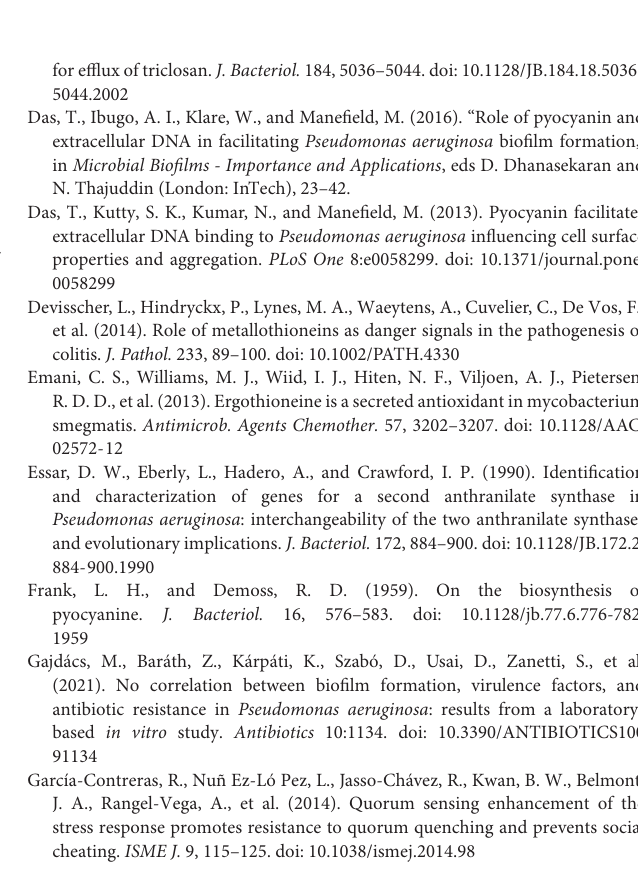
Supplementary Table S1 | Bacterial strains and plasmids used in the present study. Supplementary Table S2 | Primers used in the present